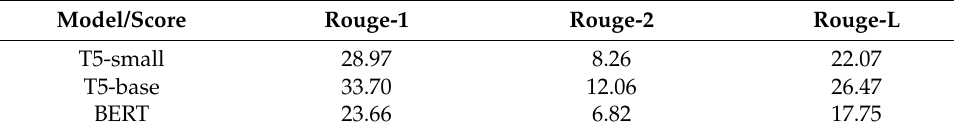
Table 4. Performance evaluation (output length: 150).